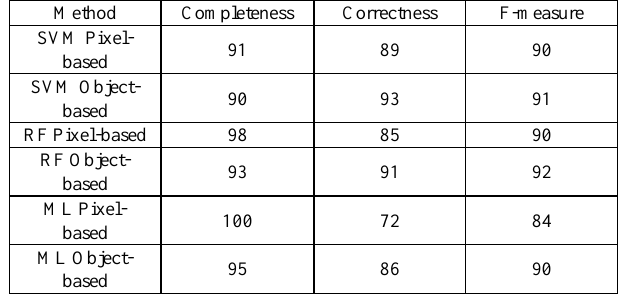
Table 2 contains the best object-based result versus pixel-based result for each classifier. This enables us to compare the result of pixel-based and object-based shadow detection. Table 2. Comparison on object-based and pixel-based result of shadow